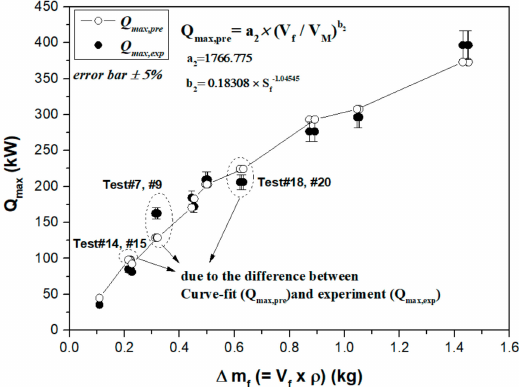
Figure 10. Comparison of the maximum heat release rate of experiments and predictions with mass loss.